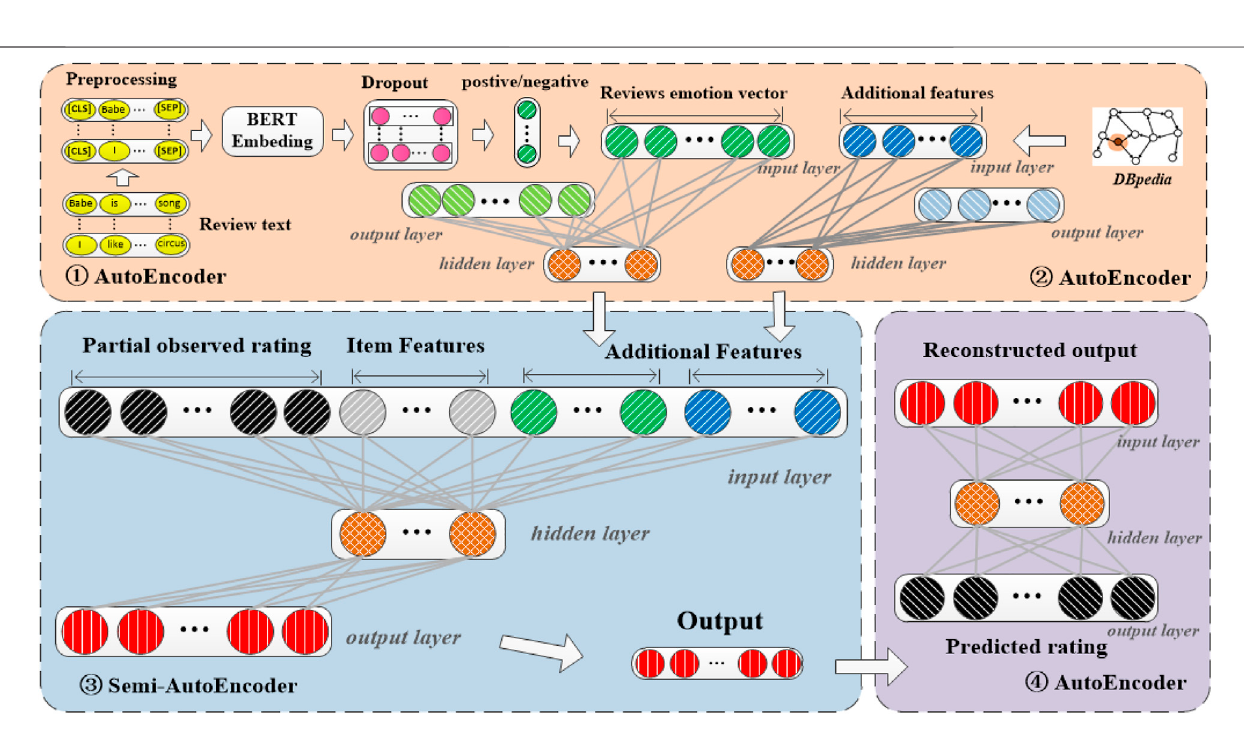
third autoencoder. Different from the semi-autoencoder model that reconstruct all the input for the recommendation 3,4 .